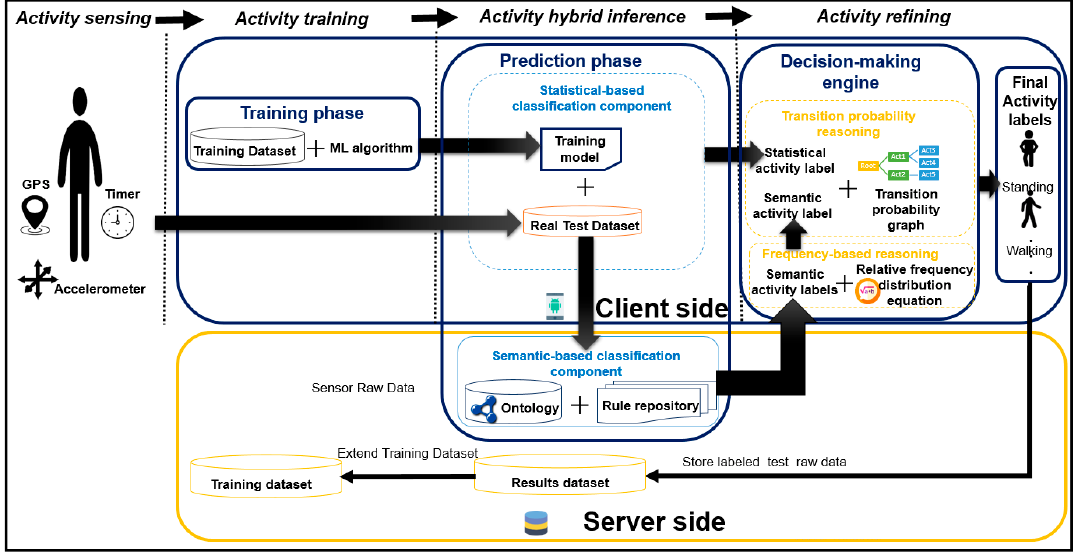
Figure 4. Framework